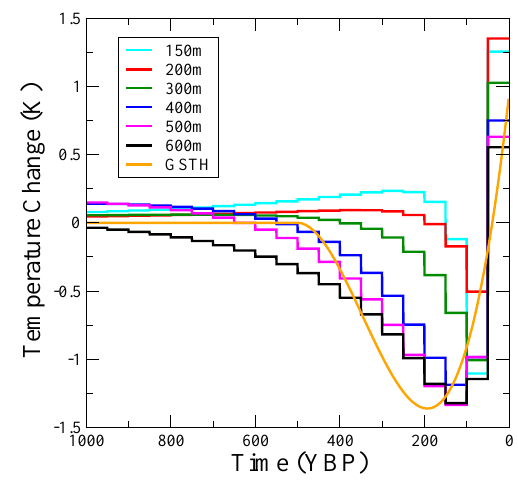
Fig. 4. Ground surface temperature histories obtained from a SVD inversion of the synthetic subsurface temperature anomalies in Fig. 2. The GST models in all of the inversions consist of a series of twenty 50-year time steps, evenly spaced over the 1000-year pe- riod. The legend indicates the maximum depth of the temperature log for each inversion. The “true” synthetic GST history is shown in orange and is the same curve shown in Fig. 1a. A thermal diffusivity of 10 − 6 m 2 s − 1 was assumed in all of the